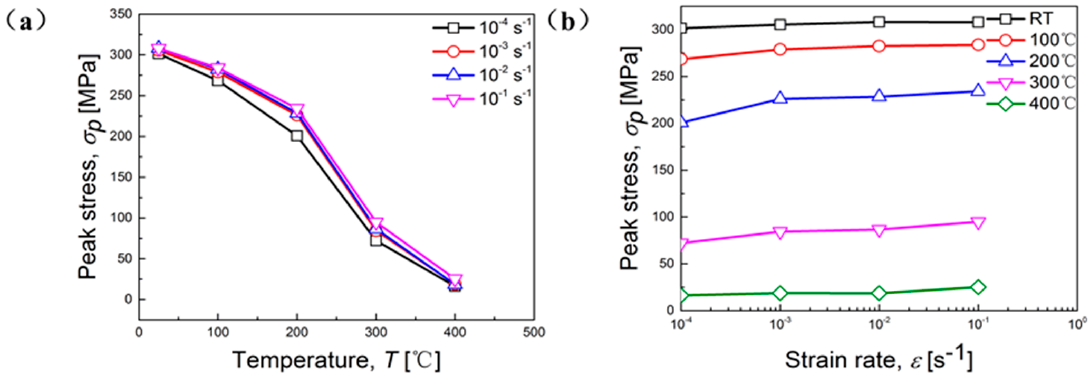
Figure 5. Peak stress as a function of: ( a ) Temperature; ( b ) strain rate.